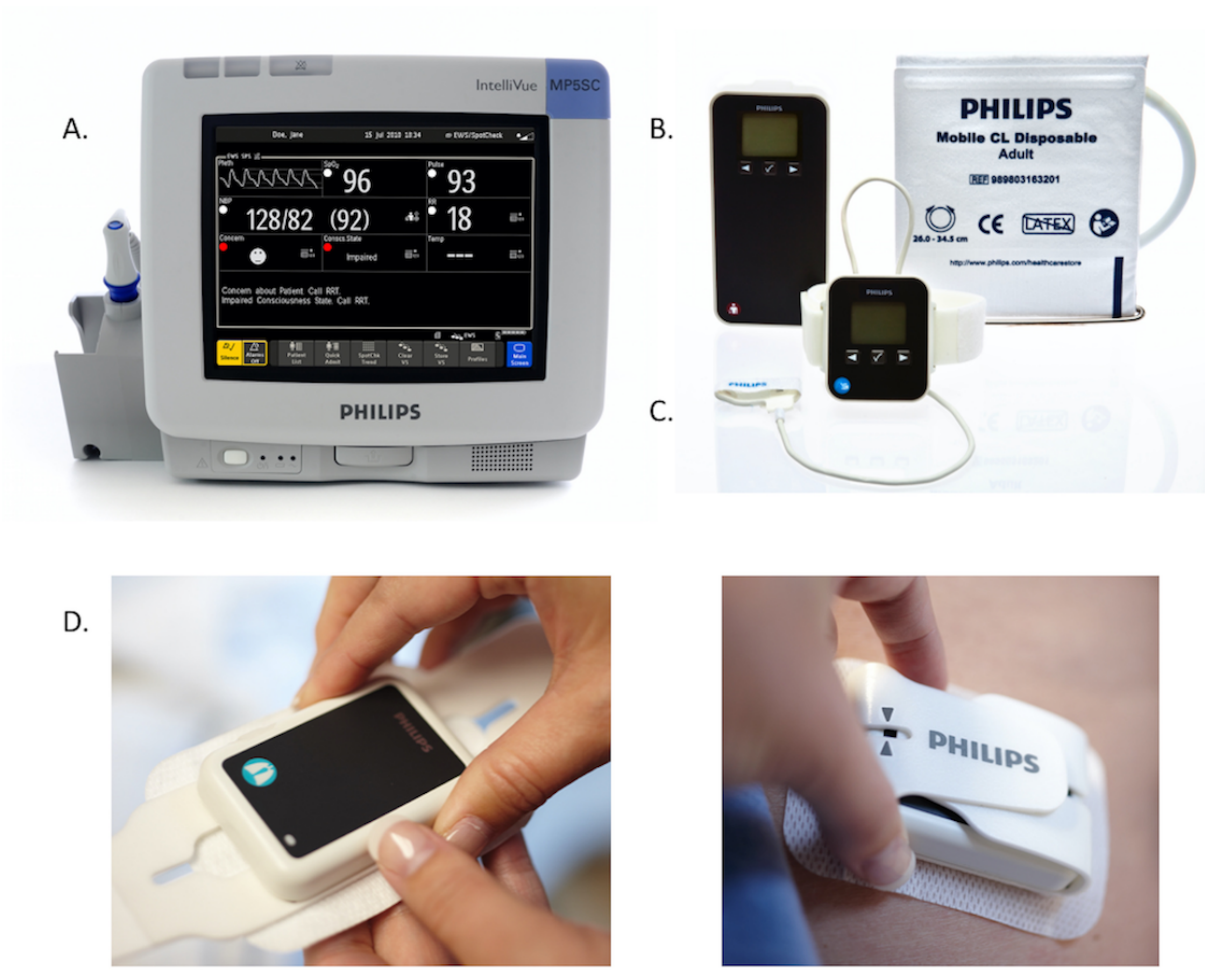
Figure 1. The Philips Guardian Solution. (A) MP5 spot-check monitor, (B) wireless blood pressure monitor, (C) wireless continuous pulse oximetry monitor, and (D) wireless respiratory sensor. Reproduced with permission from Philips Canada (Markham, ON) (reprinted with copyright permission from the